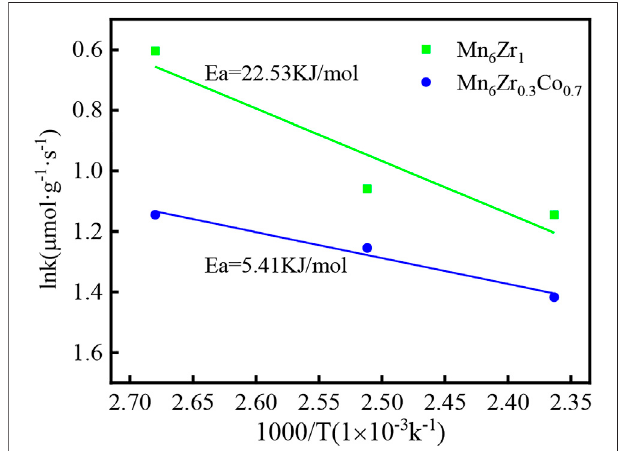
FIGURE 10 | Arrhenius diagram of Mn 6 Zr 1 and Mn 6 Zr 0.3 Co 0.7